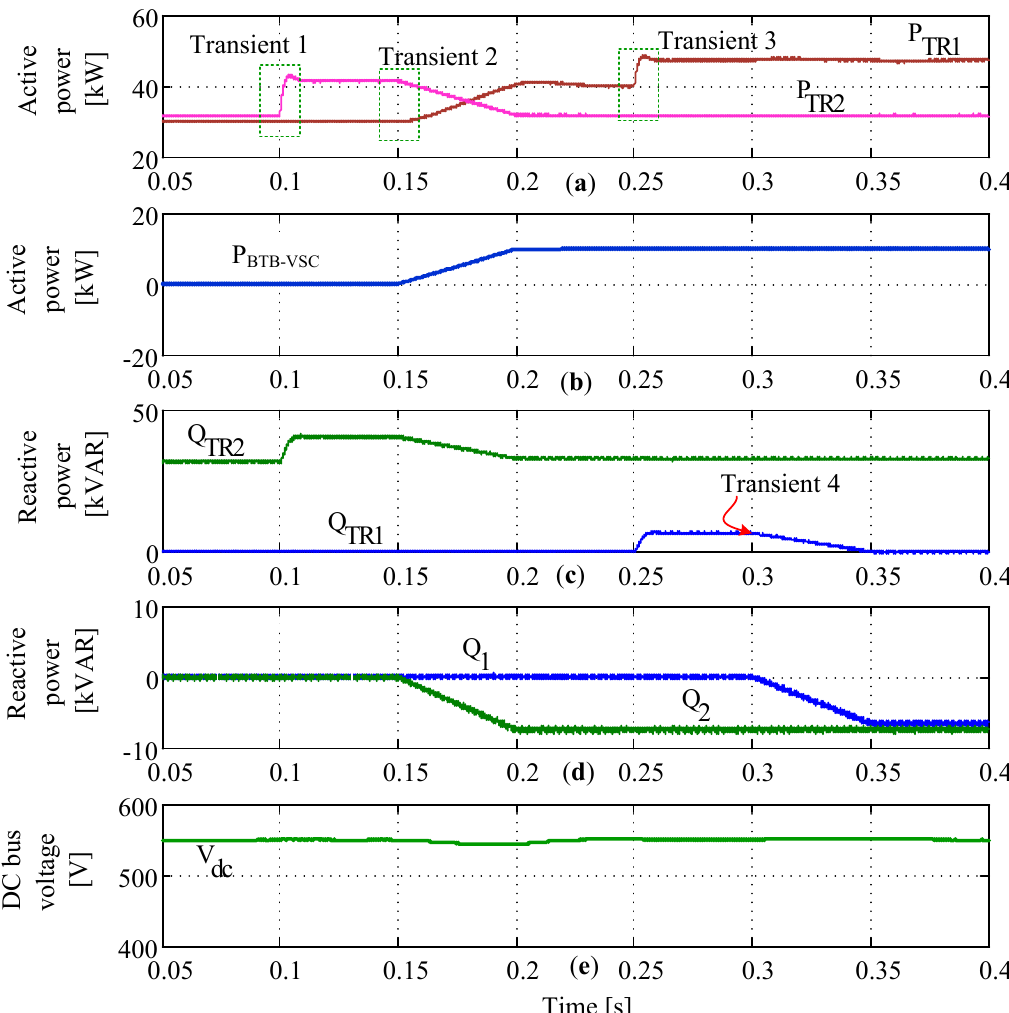
Figure 7. Case 8. ( a ) Active power for transformers TR1 and TR2. ( b ) Active power regulated with the BTB-VSC. ( c ) Reactive power for TR1 and TR2. ( d ) Reactive power compensated by the BTB-VSC. ( e ) direct current (DC) bus voltage.